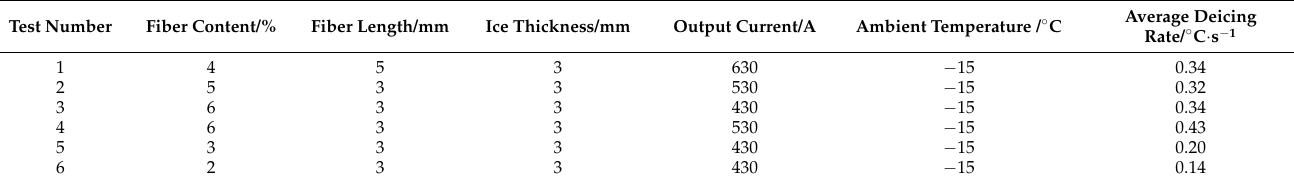
Table 6. The confirmation samples of original data.